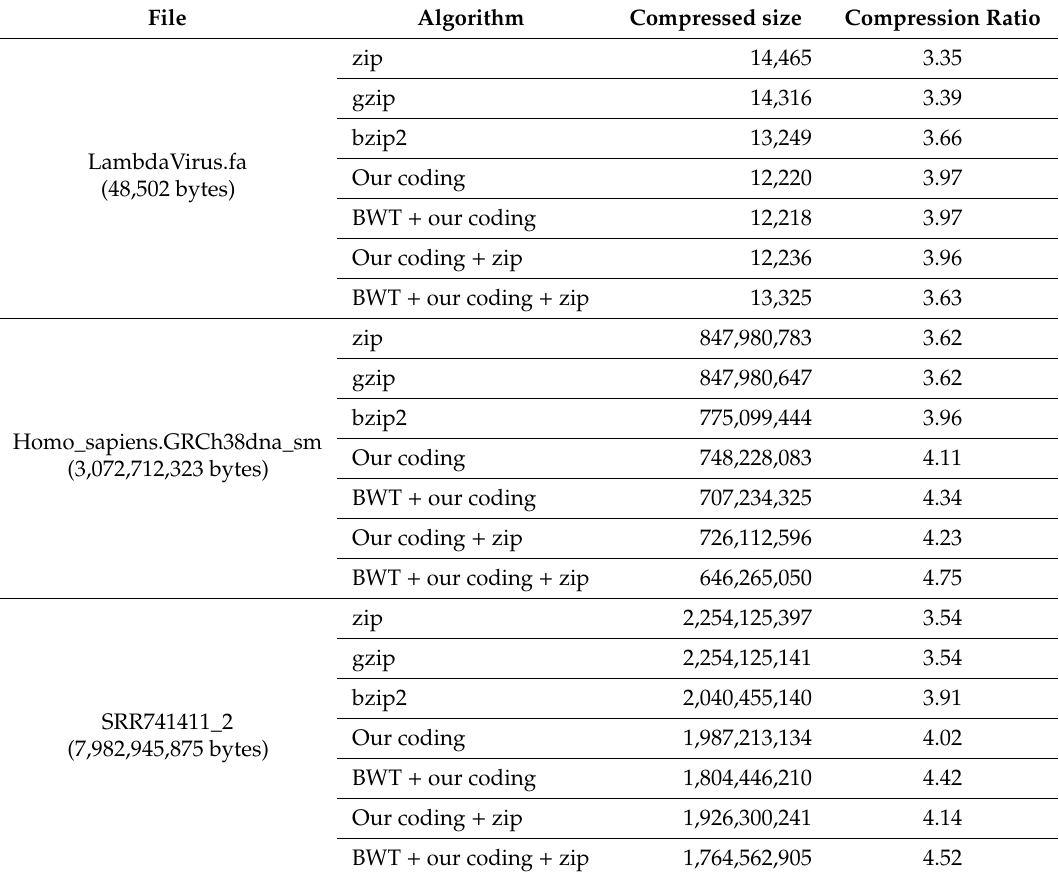
Table 2. Experimental results